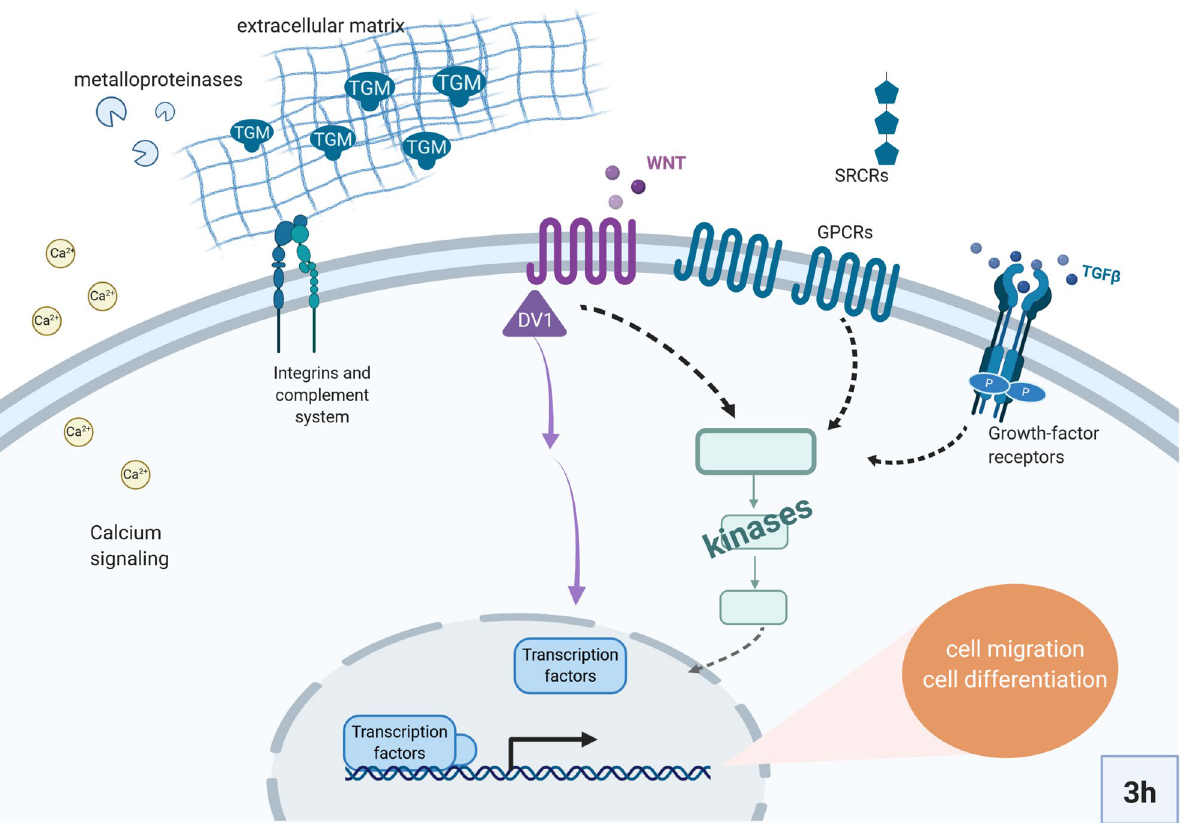
Figure 4. Suggested reconstruction of the sponge response to wounding at 3 h. Schematic representation based on the set of annotated DEGs. The localization of the proteins and their interactions are proposed according to literature or annotation of transmembrane domains. We hypothesize that the observed transcriptomic response may regulate cell migration and differentiation. TGM: transglutaminases. Created with